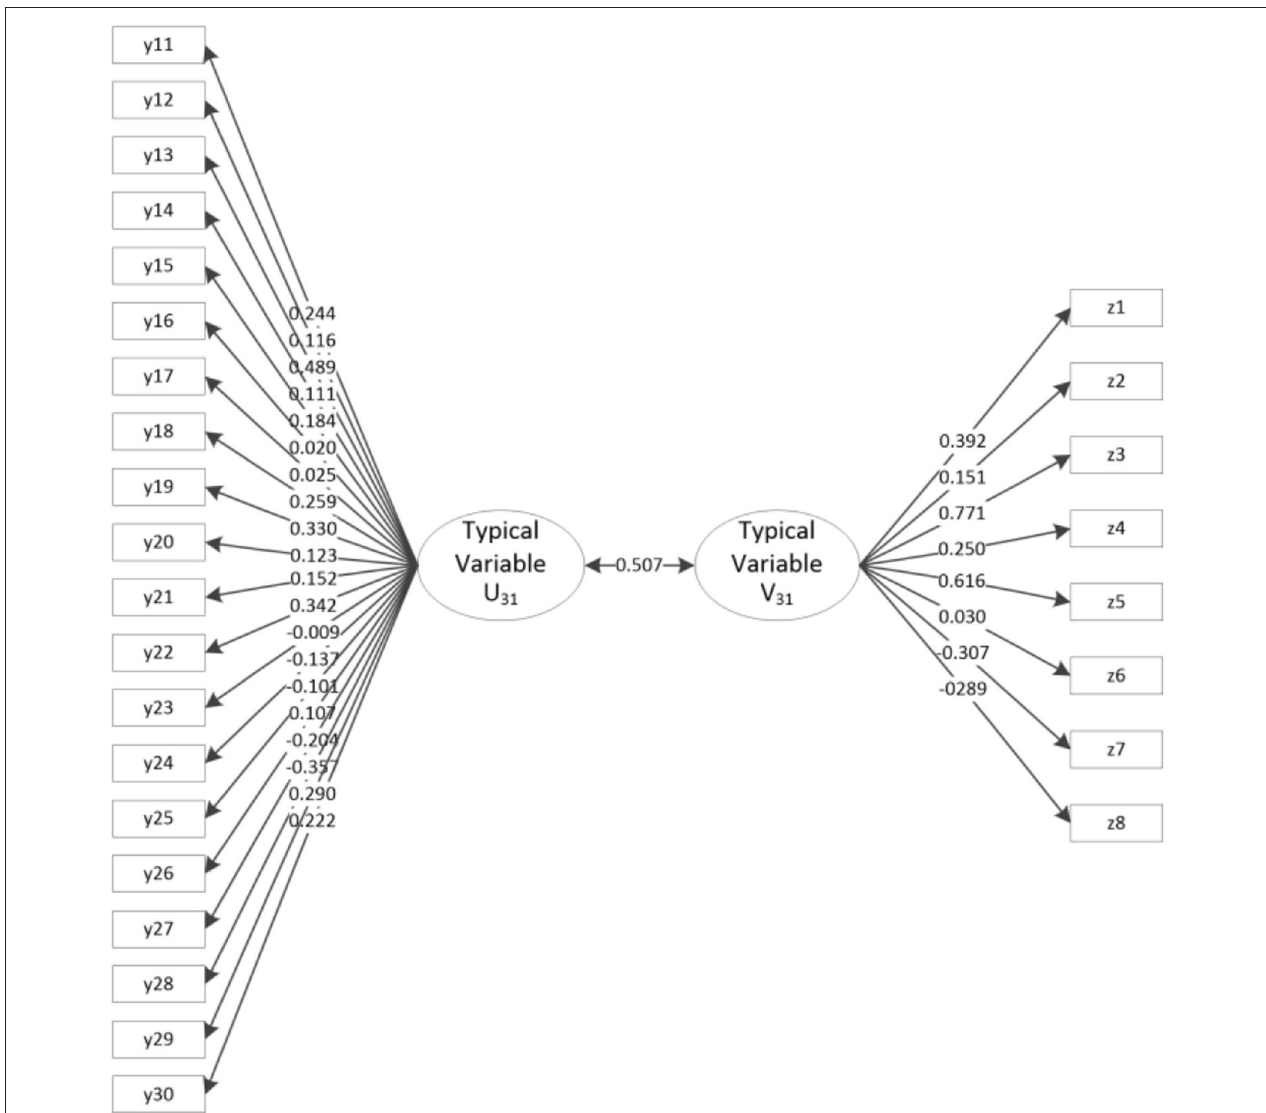
FIGURE 3 | Typical load coefficient and cross-load coefficient of motor behavior and motor development.